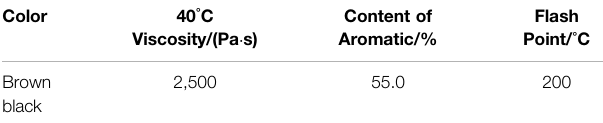
TABLE 4 | Performance of the extracted oil.